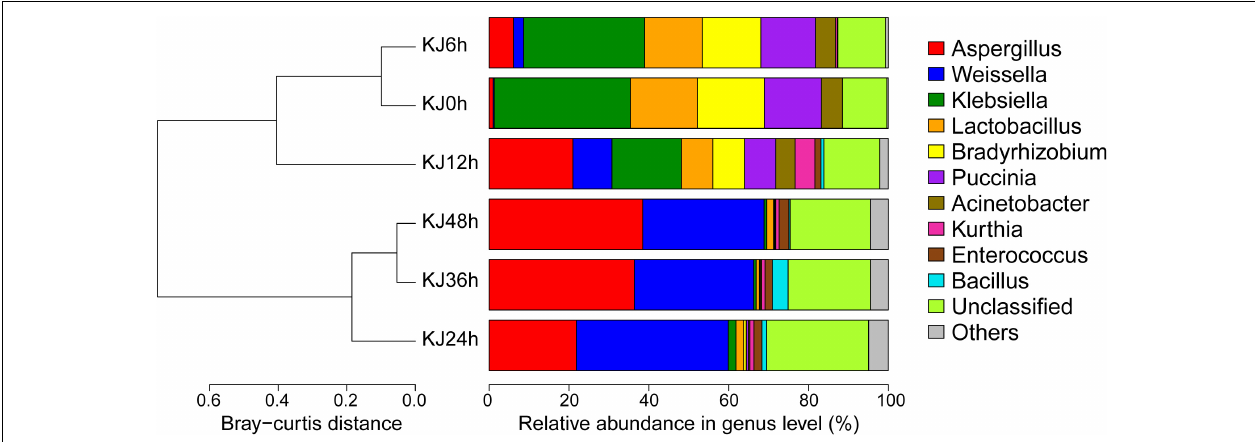
FIGURE 1 | Taxonomic composition and community compositional clustering of koji metagenomes at the genus level among six fermentation stages spanning from 0 to 48 h. The 10-most abundant taxa are shown for all samples. “Others” comprise the less-abundant genus. Sequences that could not be assigned to known taxa were designated as “unclassified”. The cluster tree is based on the Bray-Curtis distance matrix of among-sample gene